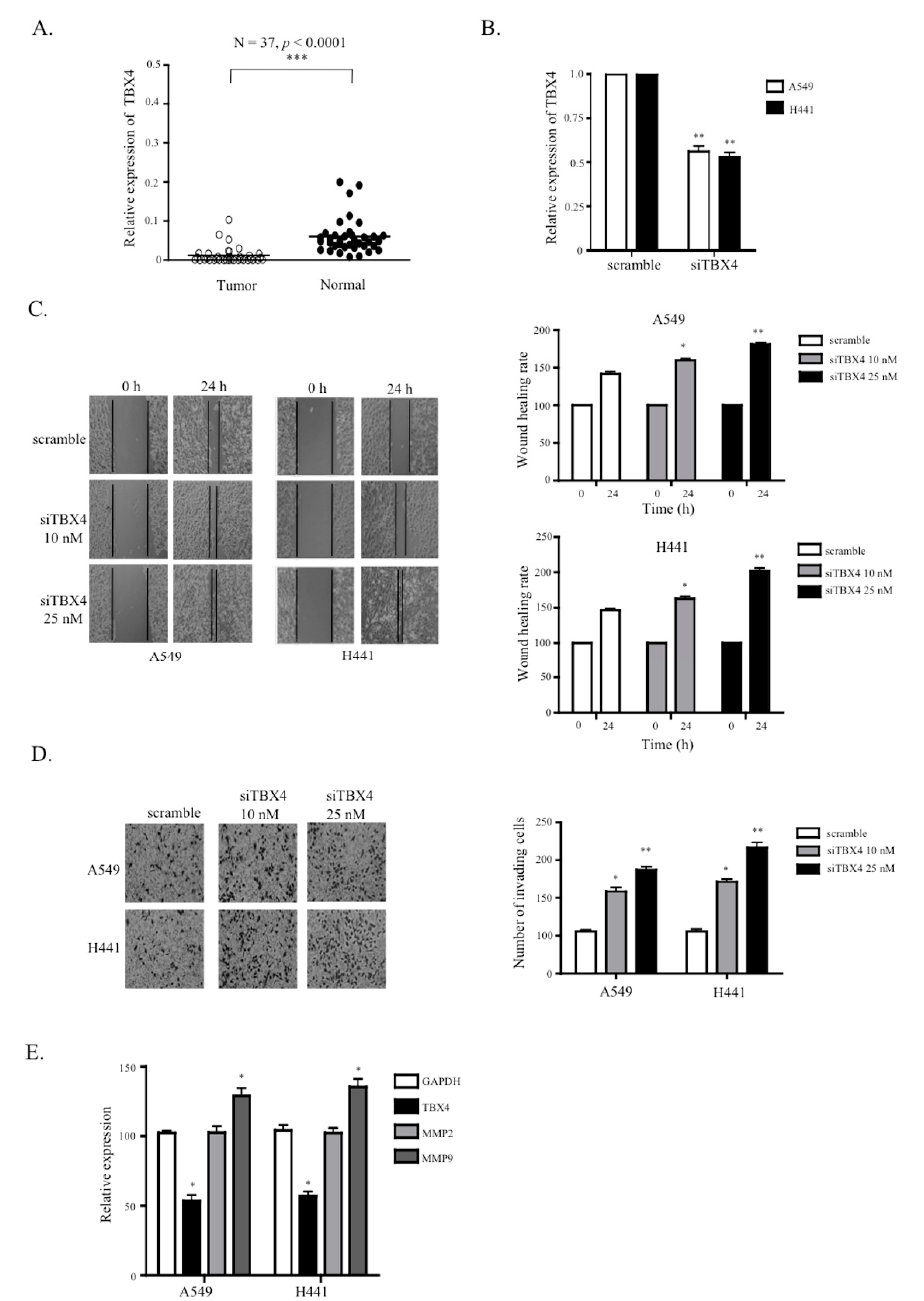
Figure 5. TBX4 was found to be downregulated in NSCLC, and the knockdown of TBX4 increased cell migration and invasion. ( A ) TBX4 is under-expressed in human NSCLC compared to the adjacent normal tissue ( n = 37 for each group). ( B ) qRT-PCR was carried out to analyze the TBX4 knockdown efficiency of TBX4-specific small interfering RNA (siTBX4) in A549 and H441 cells. ( C ) Wound scratch assays were performed to analyze the migration abilities of TBX4 knockdown A549 and H441 cells compared to the scramble cells. The statistical analysis of the inhibition rates of A549 and H441 cells were performed at 18 h. Magnification, ×200. ( D ) Transwell invasion assays were performed to determine the invasion ability of TBX4 knockdown A549 and H441 cells compared to the scramble cells. ( E ) The knockdown of TBX4 increased the expression levels of matrix metallopeptidase (MMP) 9. Data are presented as the mean ± SD; * p < 0.05, ** p < 0.01. Statistical analysis was conducted by Student’s t -test ( n = 3).